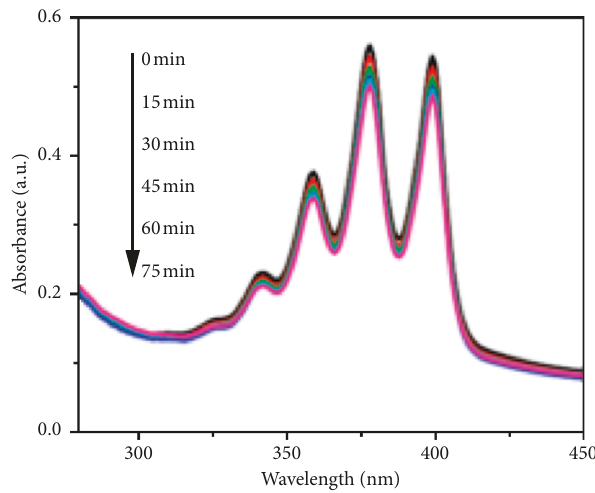
Figure 19: Graph showing a decrease in absorption of a composite AuNRs/mSiO 2 HP with ADBA with increased illumination